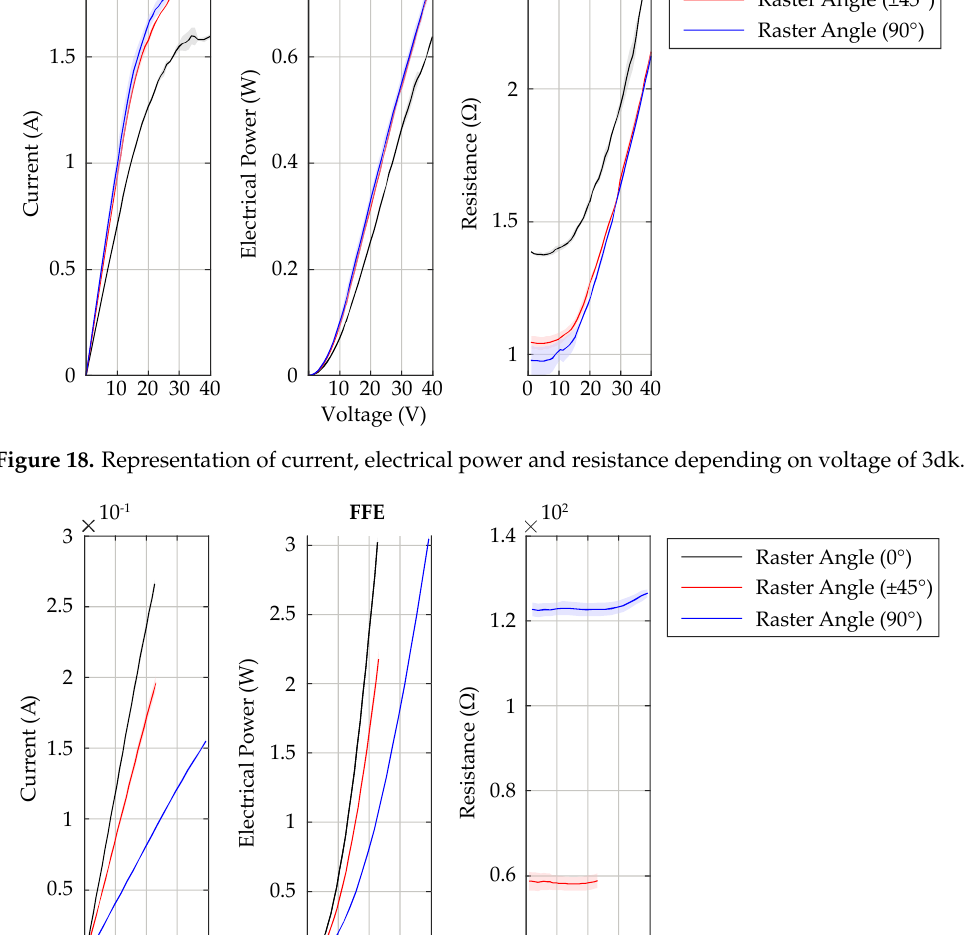
Figure 19. Representation of current, electrical power and resistance depending on voltage of FFE.